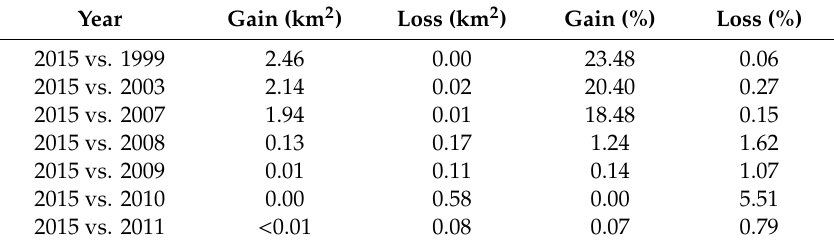
Table 3. Relative changes in vegetation cover for the time series 1999–2015, determined by a pixel-by-pixel comparison of the surface reflectance (SR) Landsat images of the year 2015 with those of the years 1999, 2003, 2007, and 2011, respectively. In the table are reported the relative increases ( gain ) and decreases ( loss ) in vegetation cover expressed as both surface (km 2 ) and percentage (%) compared to